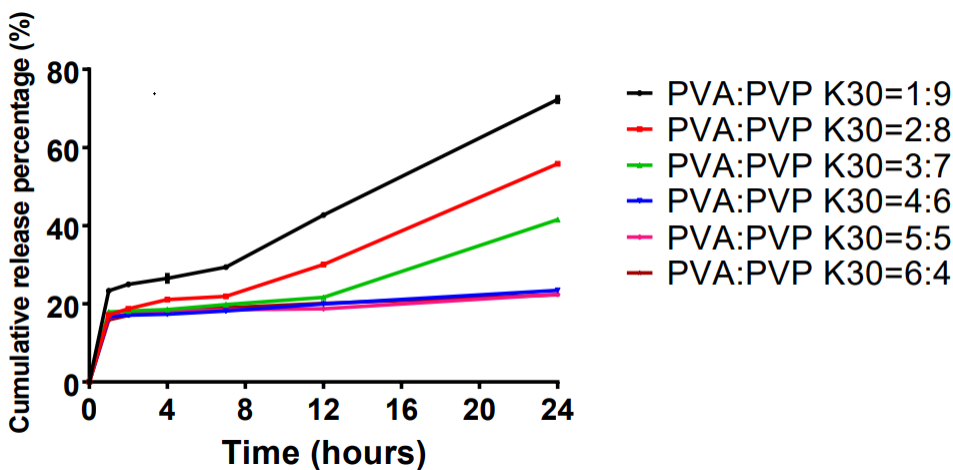
Figure 1. Effect of different ratios of PVA and PVP K30 on drug release in the LP-VPH compound transdermal drug delivery system (mean ± SD, n = 3).